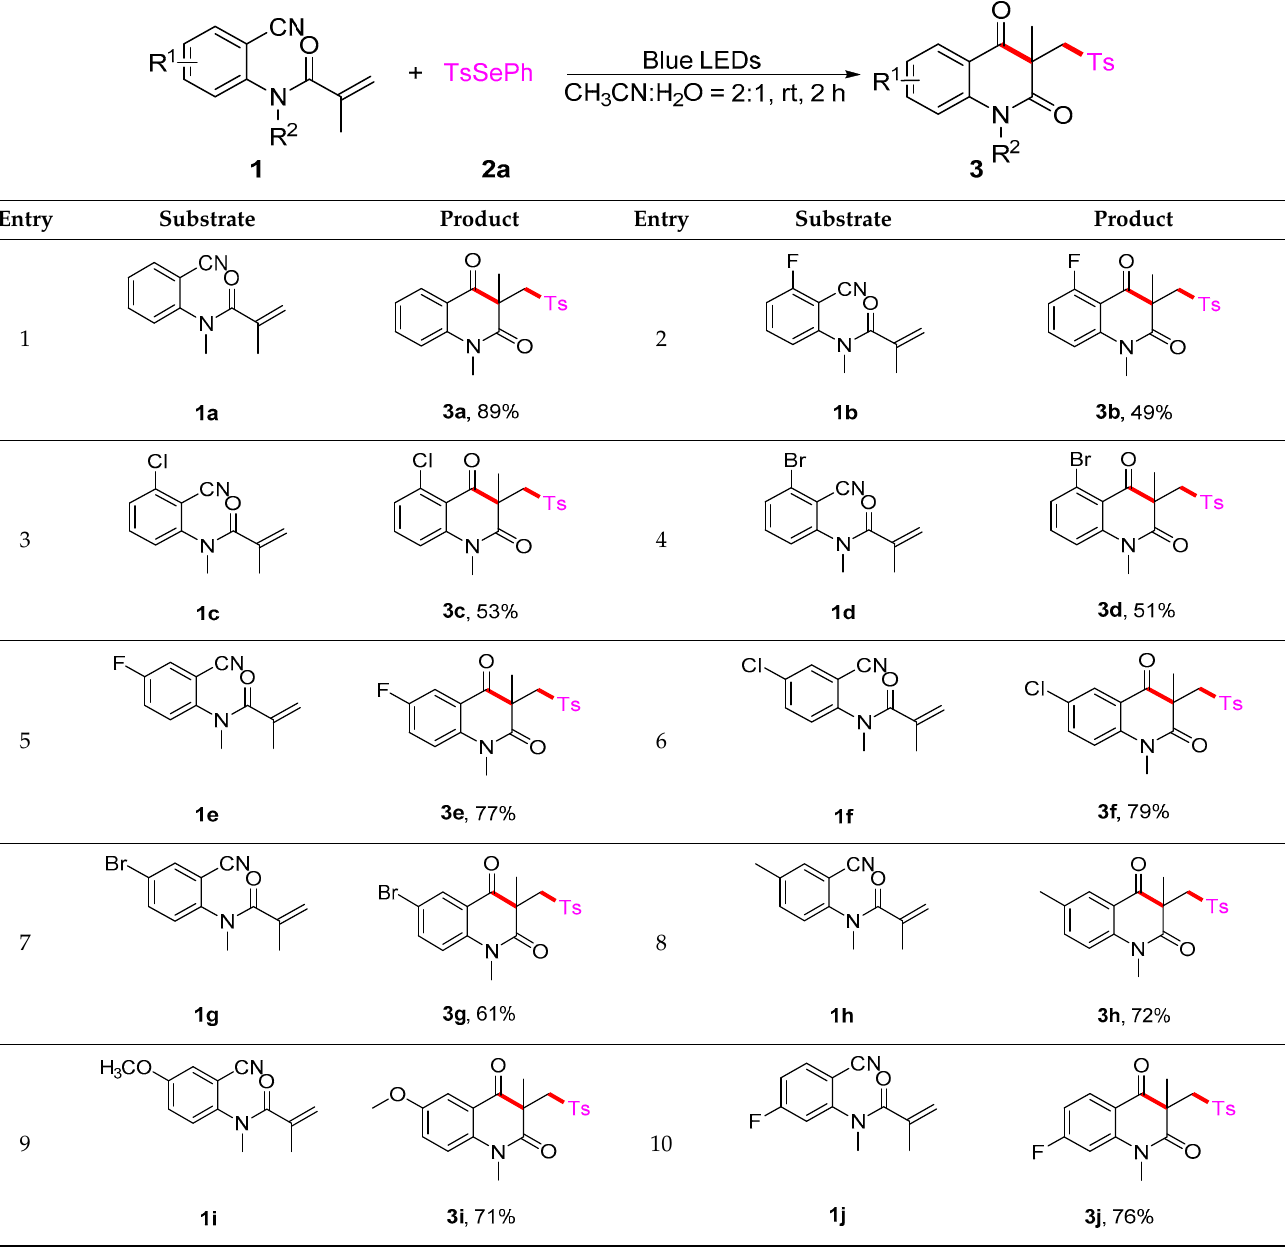
Table 2. Substrate scope of 1 a , b .